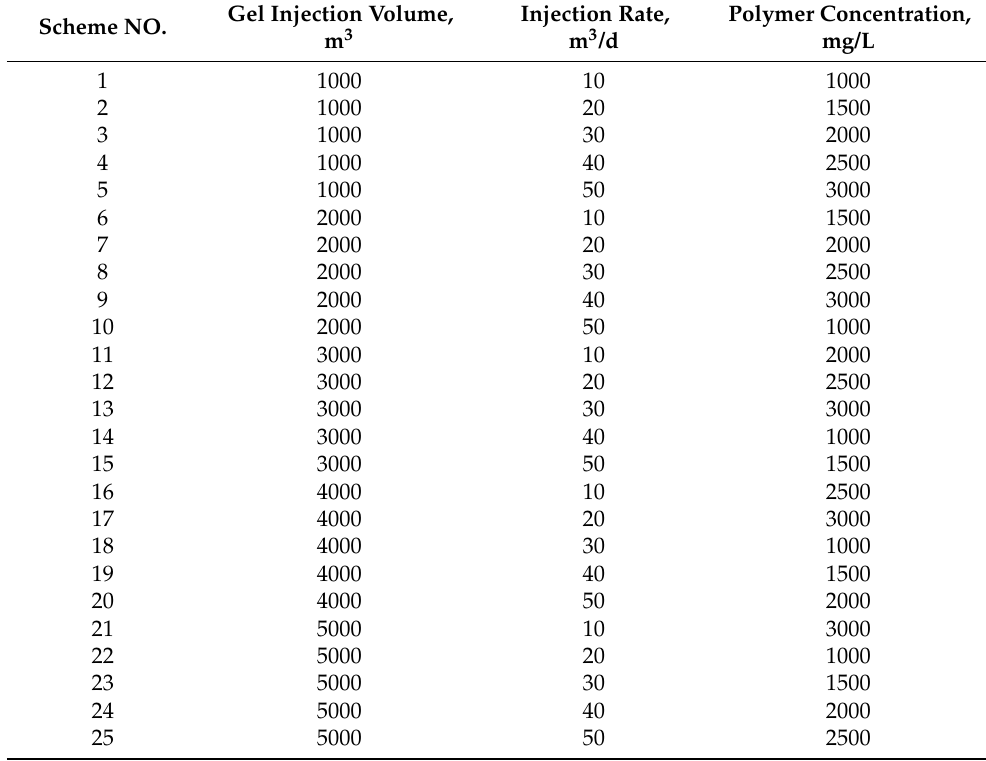
Table 7. The designed gel flooding schemes.